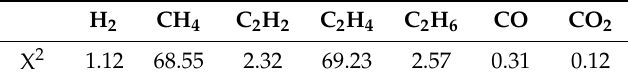
Table 4. Chi-square distribution coefficient for dissolved gases.